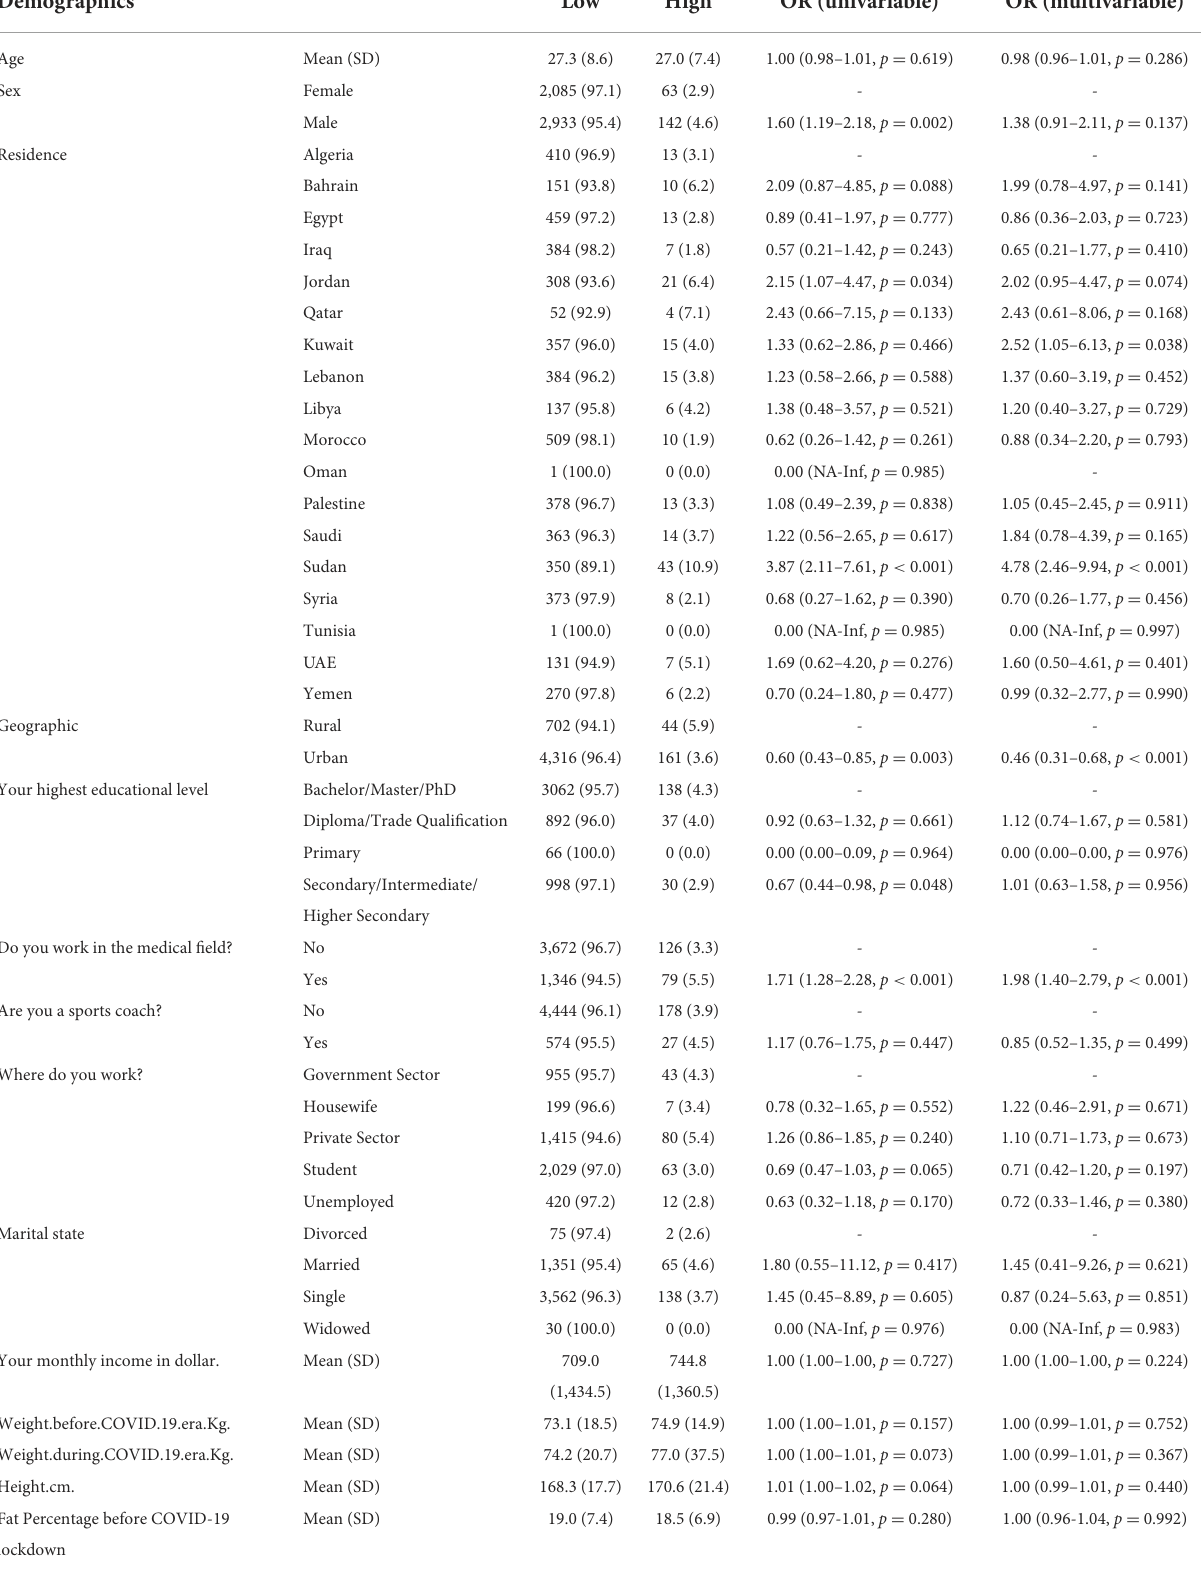
TABLE 7 Logistic regression models for the association between demographics and high level of